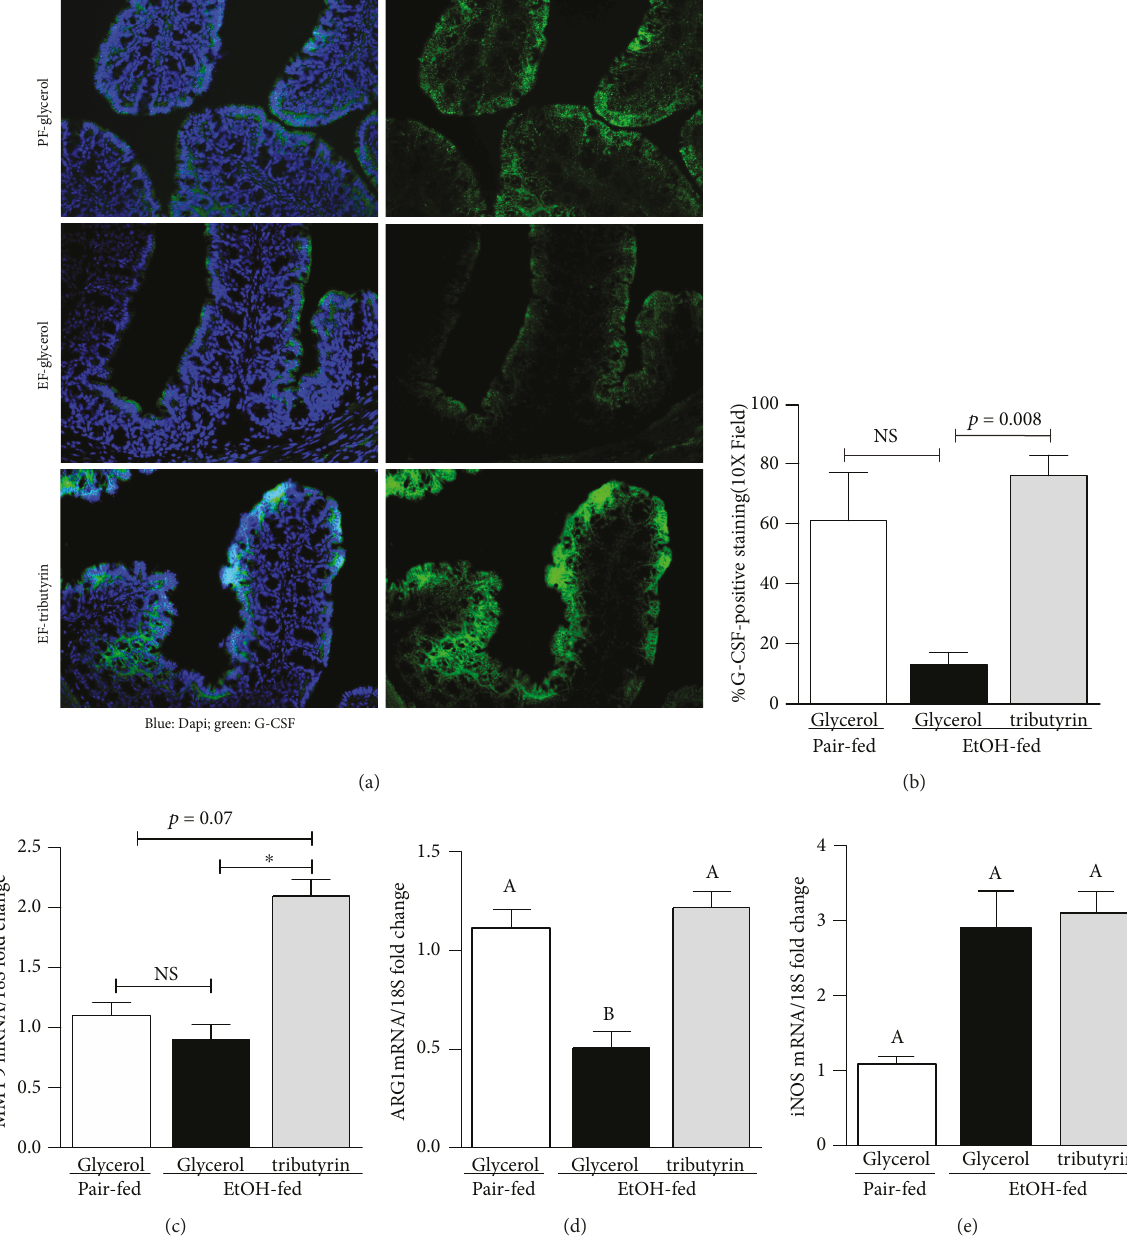
Figure 2: E ff ect of tributyrin on neutrophil and macrophage regulators in the proximal colon following chronic-binge ethanol exposure. Mice were treated as described in Figure 1, and the proximal colon was excised and used to prepare RNA or embedded in OCT for histology. (a) G-CSF (green) was visualized by immunohistochemistry in sections of proximal colon frozen in OCT. Images shown were acquired using 20x objective and are representative of at least replicate images captured per mouse in four to six mice per treatment group. (b) Images acquired using a 10x objective were quanti fi ed for G-CSF-positive areas using Image Pro Plus software and analyzed. (c – e) Expression of MMP9, Arg1, and iNOS mRNA was detected in the proximal colon using quantitative real-time reverse transcription polymerase chain reaction. Data are mean ± SEM . Values with di ff erent alphabetical superscripts were signi fi cantly di ff erent from each other; p < 0 05 and ∗ p < 0 05 ; NS=not signi fi